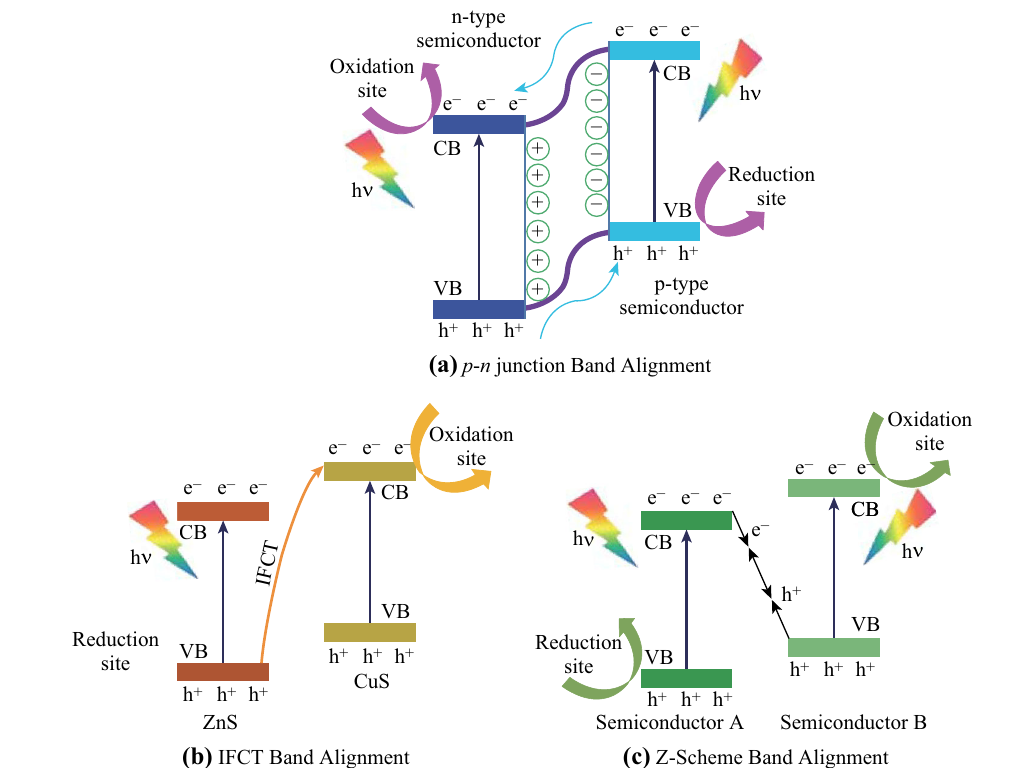
Fig. 10 Schematics of heterojunctions of a p – n junction, b IFCT and c Z-scheme. Reproduced with permission from Ref. [164, 166,